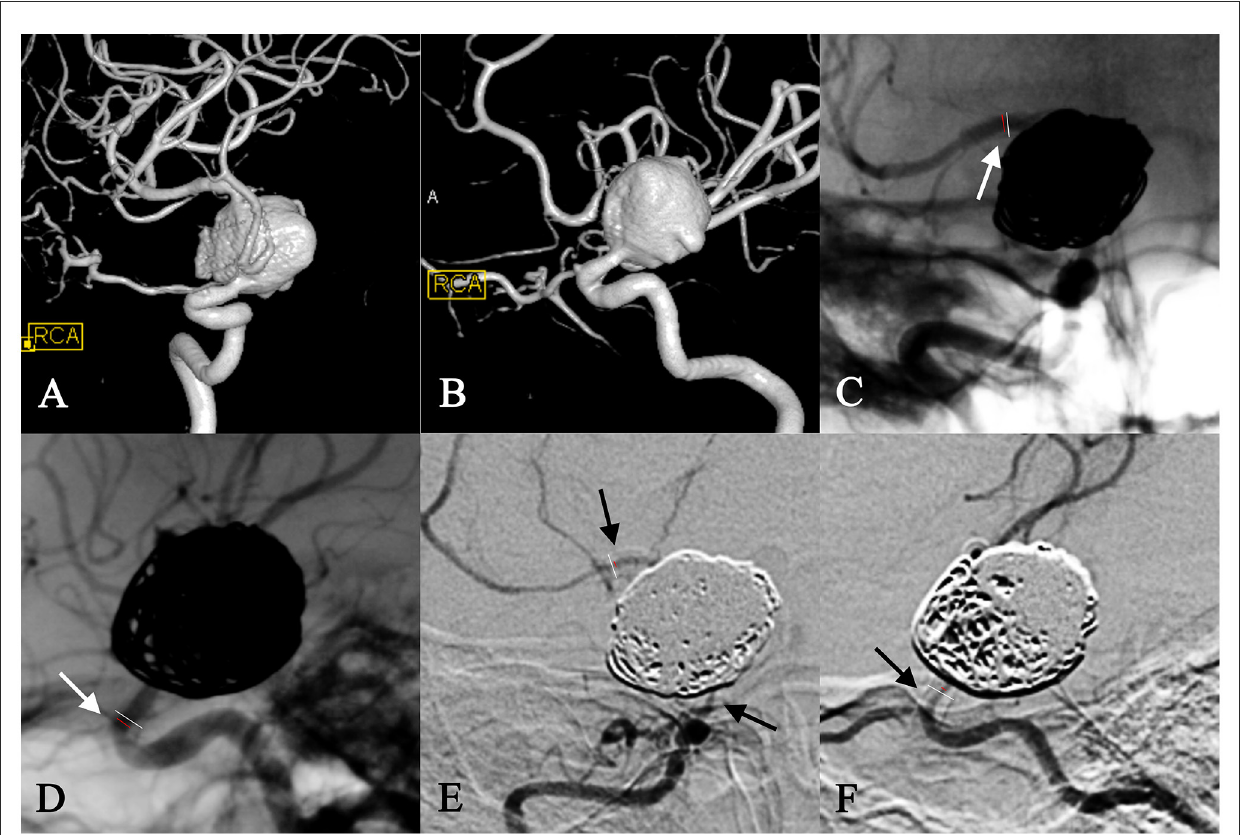
FIGURE2 In-stent stenosis in a woman in her 30s with a right carotid ophthalmic aneurysm (A, B) and treatment with PED plus coiling. At the 6-month follow-up, the frontal view of the angiography showed 15% in-stent stenosis at the distal end of the stent (C), and the lateral view of the angiography showed 65% stenosis at the proximal opening of the stent (D) . This patient developed left hemiplegia due to a right cerebral infraction 10 months after surgery, which was relieved by a thrombolysis at the local hospital. ISS in this case aggravated to 90% diffuse stenosis at the 18-month follow-up (E, F) and was subsequently treated by a vascular bypass between the superficial temporal artery and middle cerebral artery.